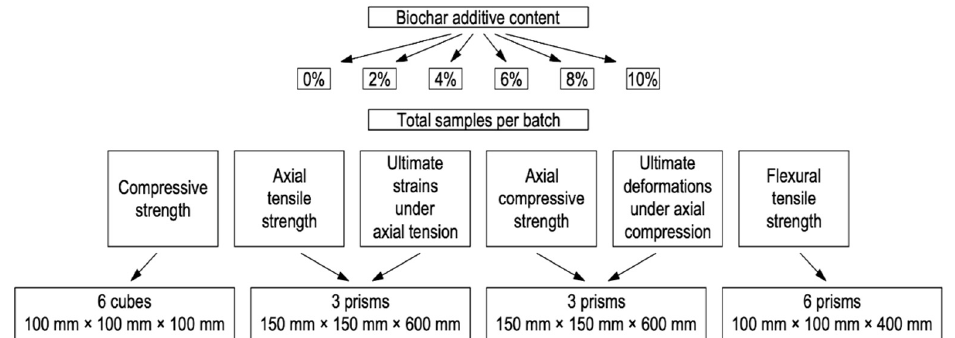
Figure 4. The program of experimental studies on the effect of dosage of rice straw biochar on the strength and deformation characteristics of concrete.